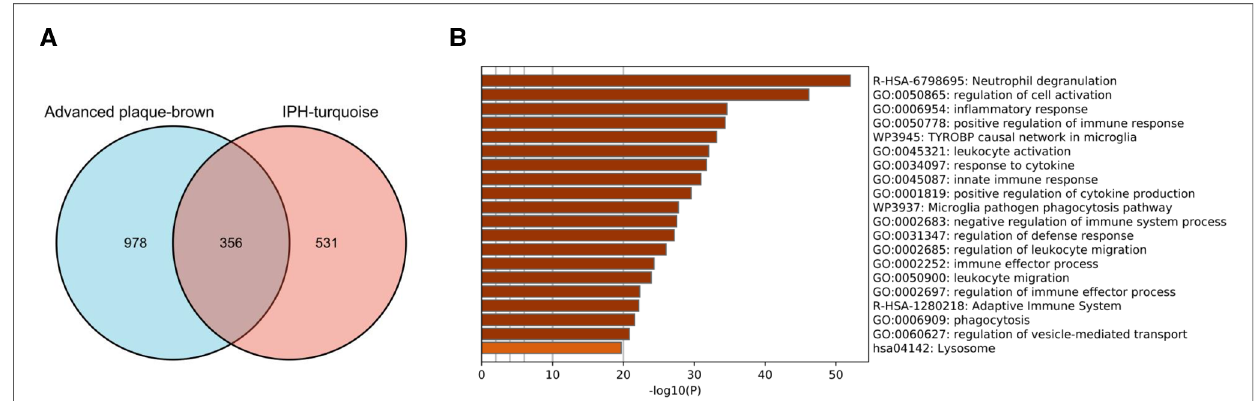
FIGURE 3 Identi fi cation of commonly expressed genes and pathway analysis. ( A ) The shared genes (SET1) between the brown modules of advanced plaques in GSE28829 and the turquoise modules of IPH plaques in GSE163154. ( B ) Signaling pathways signi fi cantly enriched in SET1. IPH, intraplaque